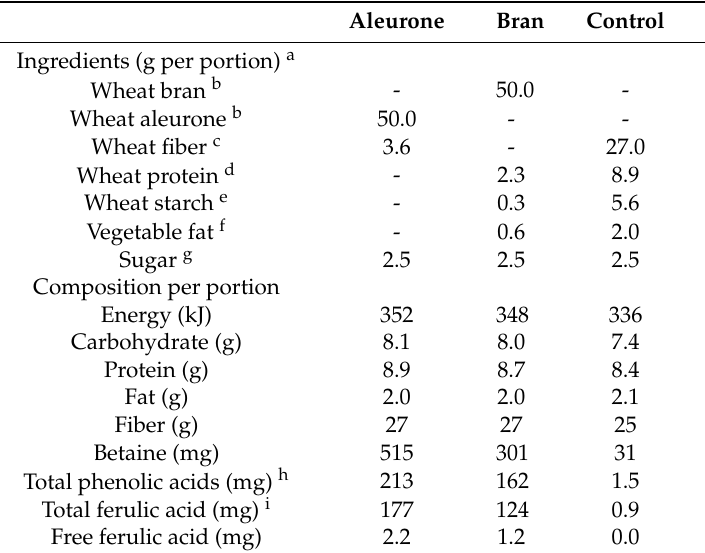
Table 1. Formulation and composition of the treatments. Aleurone Bran